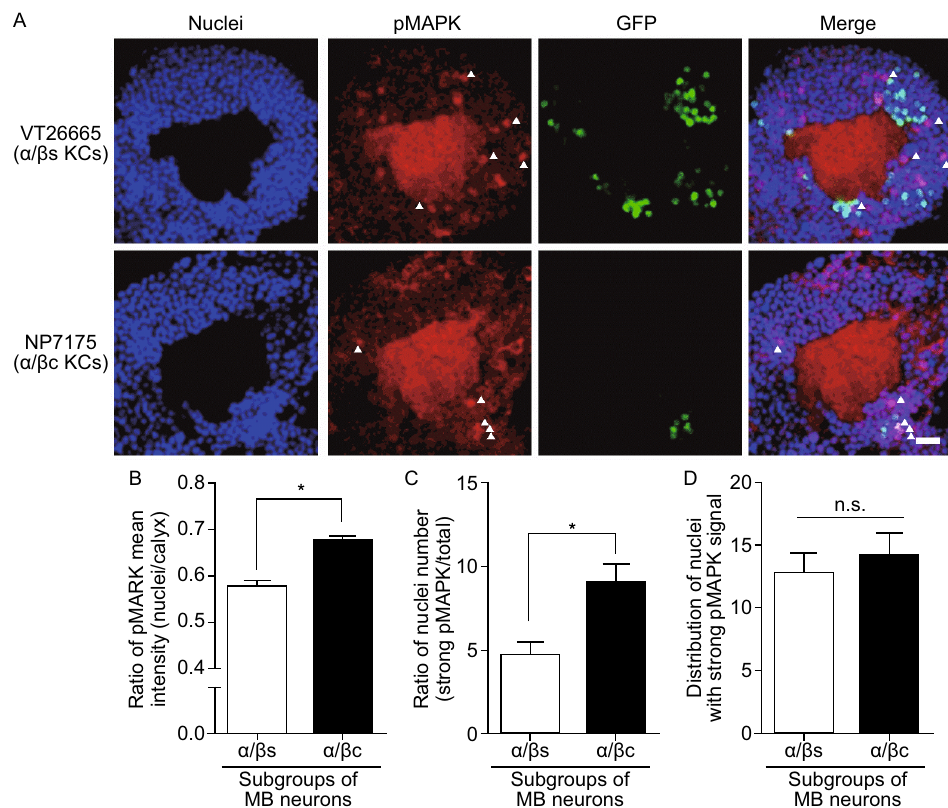
Figure 2. Distribution of nuclear pMAPK signal in two subgroups of α / β KCs during consolidation . (A) Representative images of pMAPK signal in different types of α / β KCs at 8-h after spaced training. Indicated Gal4 lines were crossed to fl ies with the genotype UAS-nlsGFP and detected by confocal imaging of whole adult central brain. Nuclei are labeled by blue color. pMAPK signal is displayed as red color. Gal4-drived expression of nlsGFP is shown as green color. Five representative nuclei with strong pMAPK signal are marked by white triangle. Scale bar is 10 μ m. (B) Statistical analysis as re fl ected in mean intensity ratio of pMAPK signal (Gal4-labeled nuclei vs. calyx). α / β c KCs showed signi fi cantly higher ratio of pMAPK mean intensity than α / β s KCs. Bars, mean ± SEM ( n = 6 – 7); * P < 0.05. (C) Statistical analysis as re fl ected in nuclear number ratio of strong pMAPK signal (number of Gal4-labeled nuclei with strong pMAPK vs. number of Gal4-labelednuclei). Nuclear number ratio of strong pMAPK signal in α / β c KCs is remarkablyhigherthanin α / β sKCs.Bars,mean±SEM( n =6 – 7);* P <0.05.(D)Statisticalanalysisasre fl ecteddistributionofnucleiwith strong pMAPK signal. No signi fi cant difference was found between α / β c and α / β s KCs. Bars, mean ± SEM ( n = 6 – 7); * P <